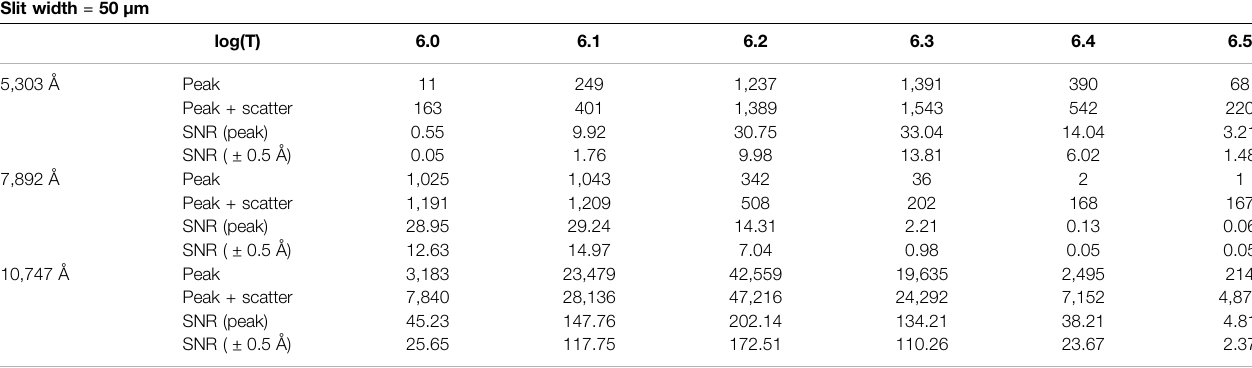
TABLE 3 | Effect of different plasma temperatures on the SNRs of the VELC spectral channels estimated at 1.1 R ʘ . Slit width = 50 μ m log(T)